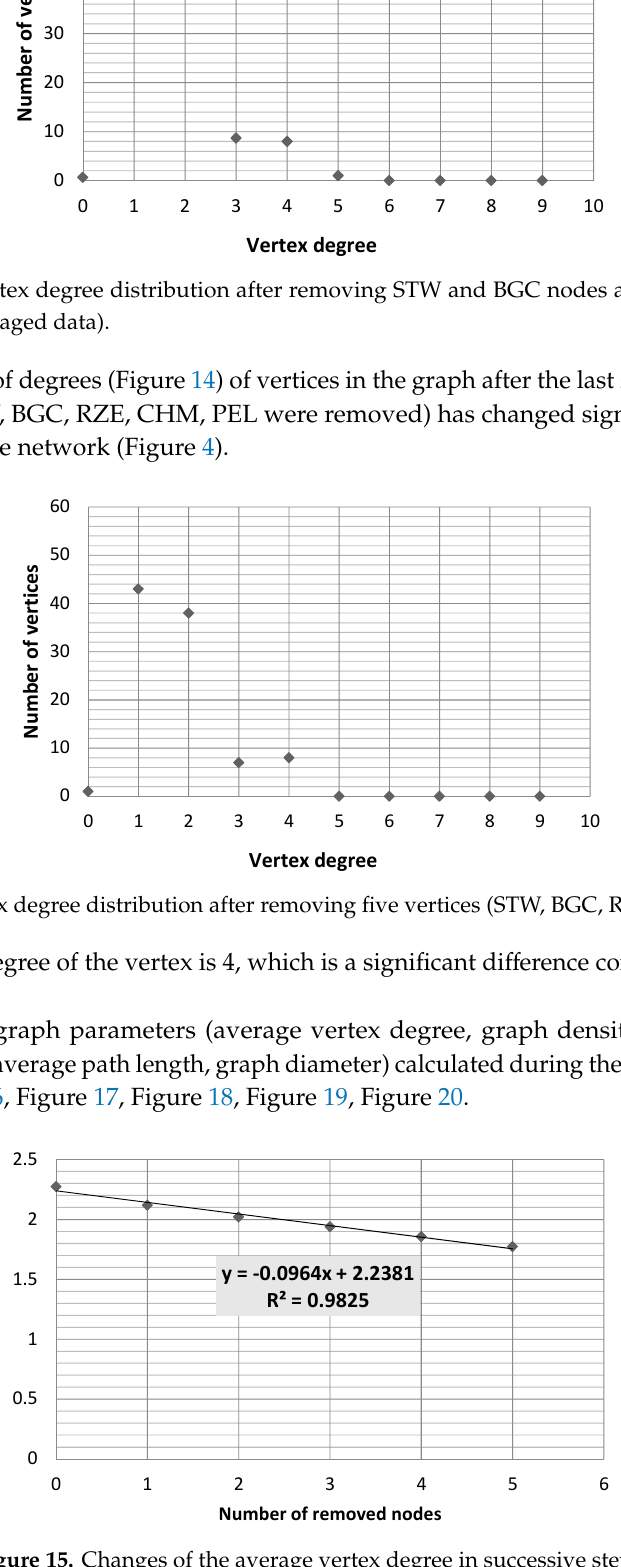
Figure 15. Changes of the average vertex degree in successive steps.